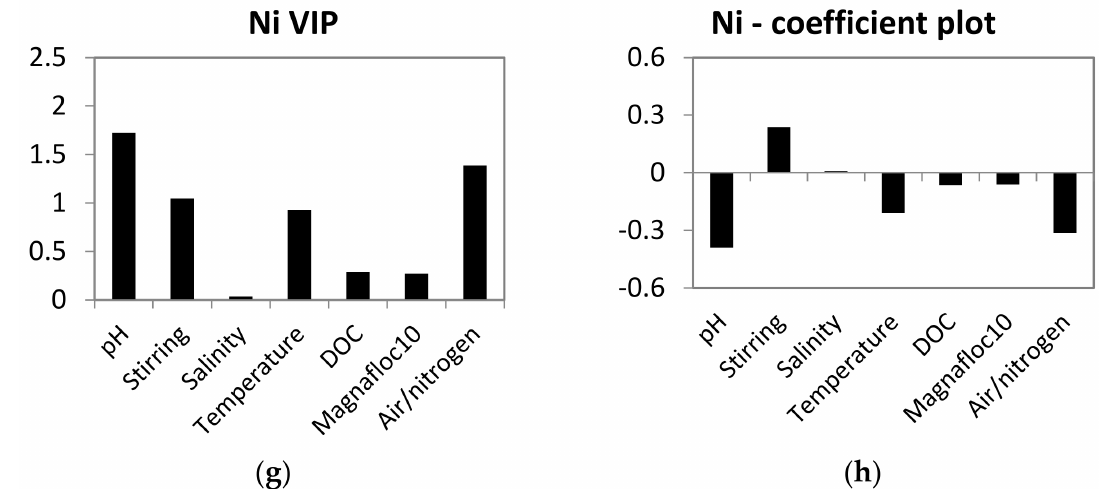
Figure 2. Variable importance in the projection (VIP) and coefficient plots for the PLS models of metal leaching. Parameters with VIP values > 1 have high, 0.5–1 have moderate and <0.5 have low influence on the desorption of metals from the mine tailings. Parameters with coefficient values > 0 have positive correlation and coefficient values < 0 have opposite correlation with desorption of metals. ( a ) VIP plot of Mn, ( b ) coefficient plot of Mn, ( c ) VIP plot of Ba, ( d ) coefficient plot of Ba, ( e ) VIP plot of Cr, ( f ) coefficient plot of Cr, ( g ) VIP plot of Cu and ( h ) coefficient plot of